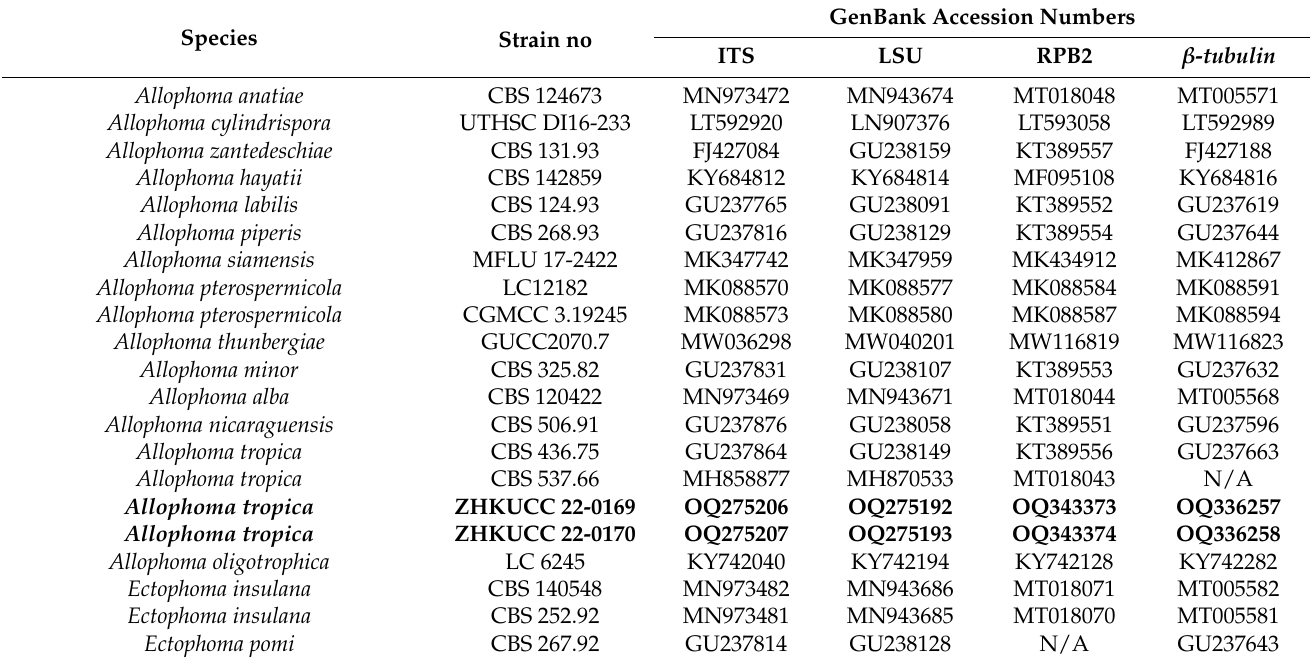
Table 2. Taxa used in the present phylogenetic analyses and GenBank numbers of their